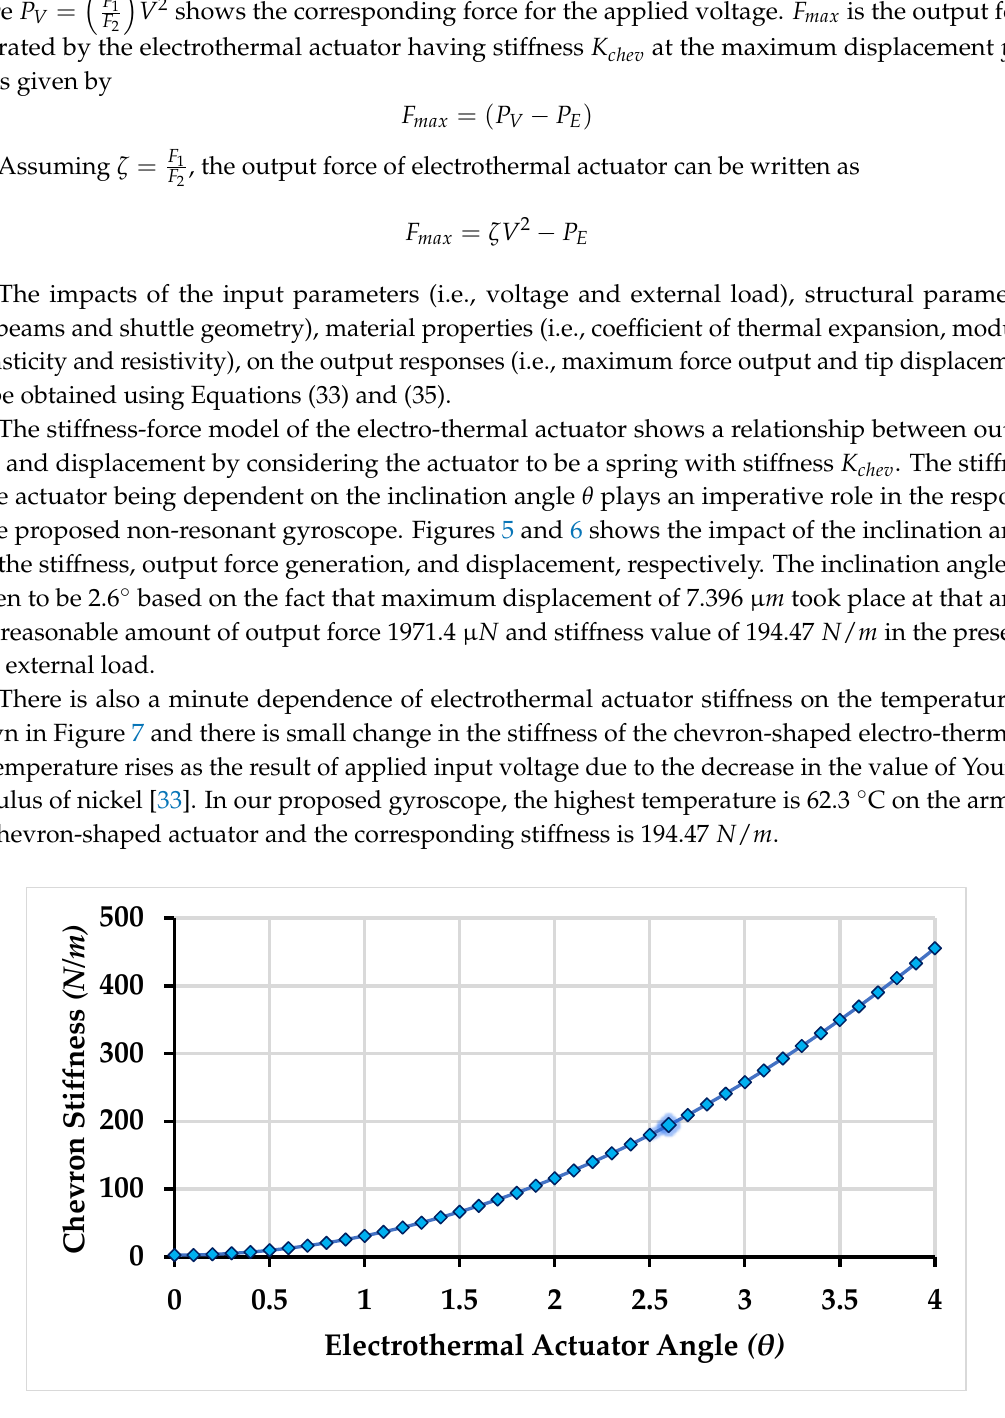
Figure 6. Force output and maximum displacement values of the electro-thermal actuator with angle variations.